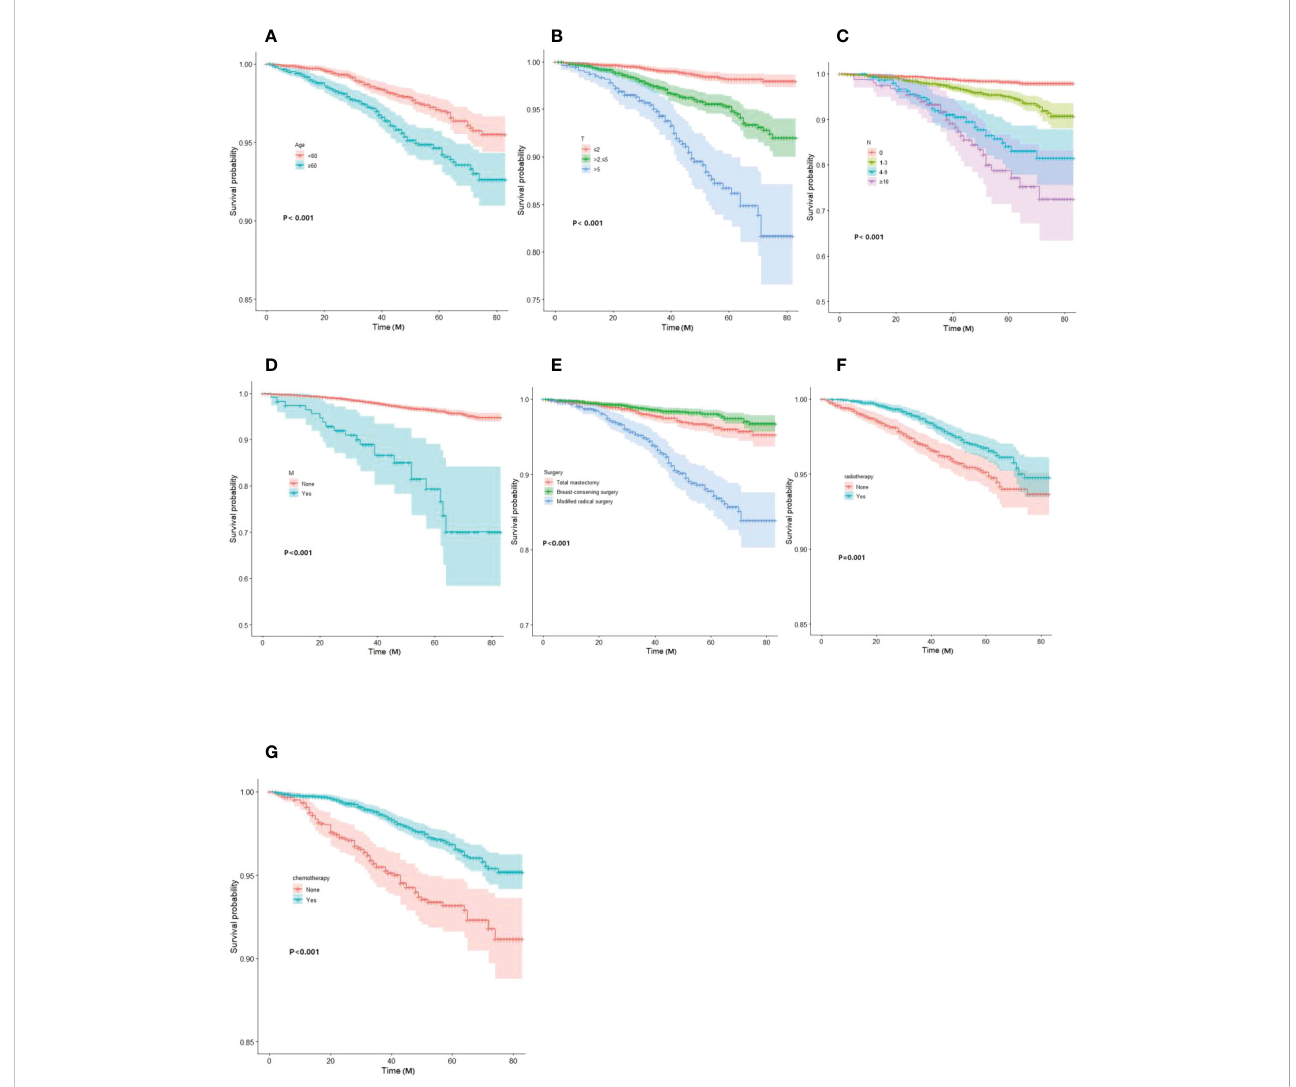
FIGURE 2 Kaplan-Meier curves of OS for each predictor. (A) Age; (B) T-stage; (C) N-stage; (D) M-stage; (E) mode of surgery; (F) radiotherapy; (G) chemotherapy. OS, overall